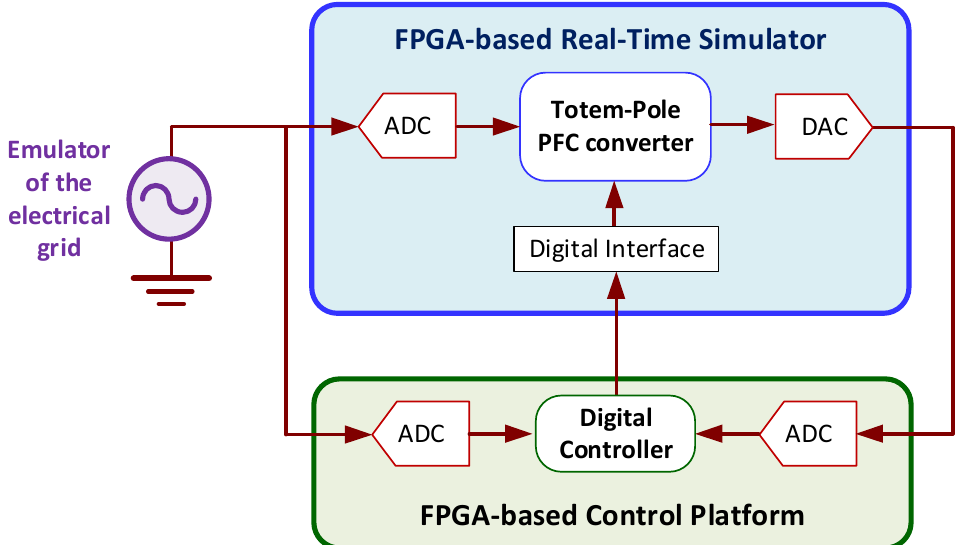
Figure 2. Schematic of the FPGA-based real time HIL simulation used in this example.